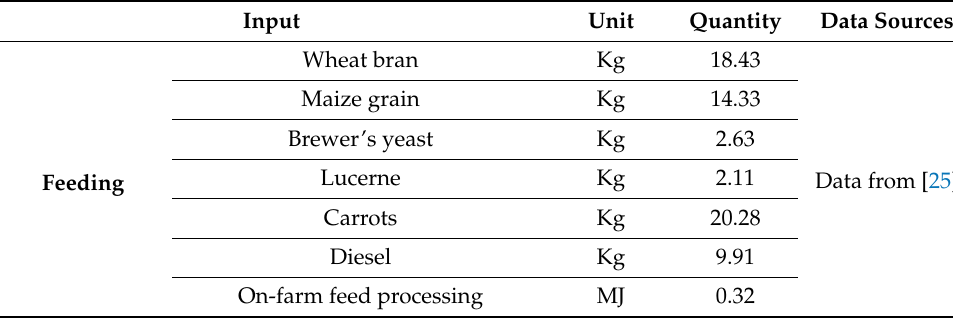
Table 1. Inputs per kg of mealworm protein Table 1 . Inputs per kg of mealworm protein (FU) .